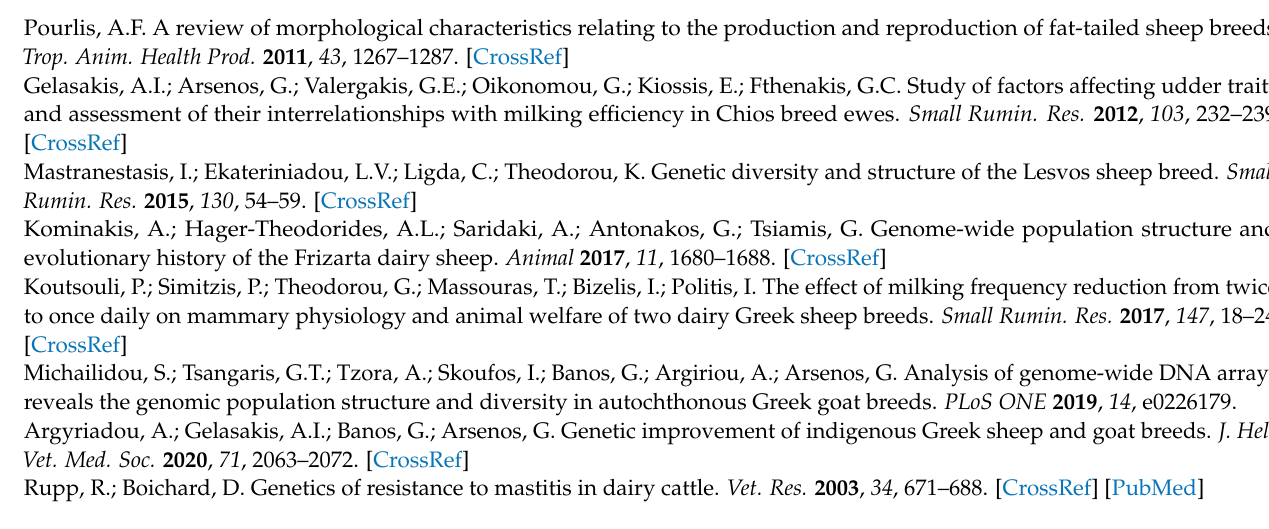
analysis. Table S4: Associations of zootechnical characteristics with increased total bacterial counts in bulk-tank milk (i.e., above 1500 × 10 3 cfu mL − 1 ) in 325 sheep farms in Greece, as found in a univariable analysis. Table S5: Associations of zootechnical characteristics with increased somatic cell counts in bulk-tank milk (i.e., above 0.75 × 10 6 cells mL − 1 ) in 119 goat farms in Greece, as found in a univariable analysis. Table S6: Associations of zootechnical characteristics with increased total bacterial counts in bulk-tank milk (i.e., above 1500 × 10 3 cfu mL − 1 ) in 119 goat farms in Greece, as found in a univariable